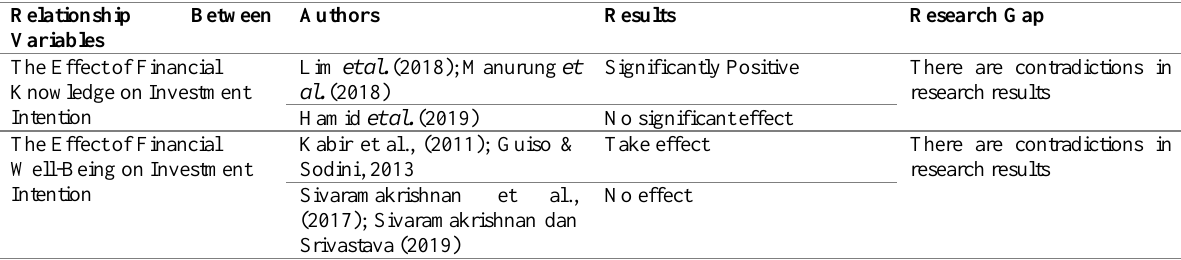
Table 1: Summary of Research